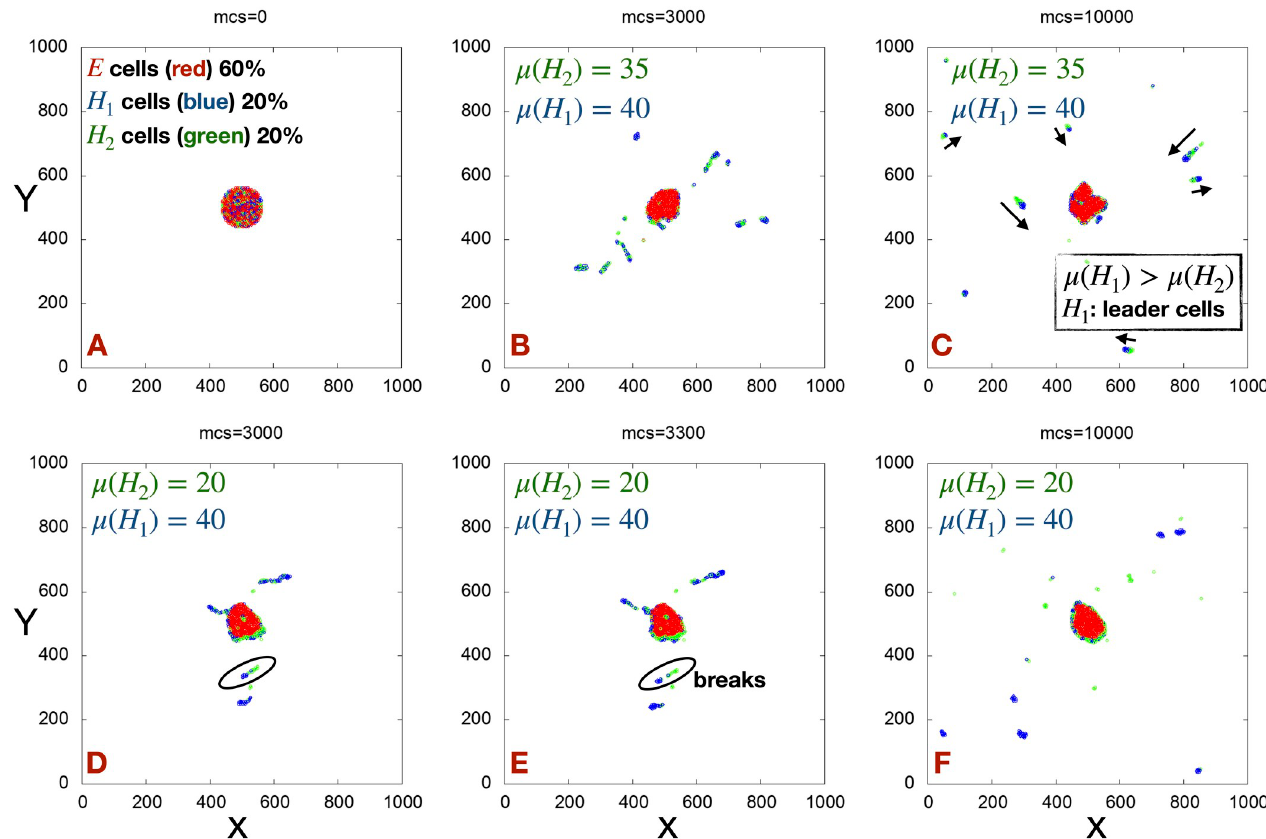
Fig 5. Snapshots of heterogeneous clusters. (A) A representative snapshot of an initial configuration consisting of two kinds of H cells ( H 1 and H 2 ) differing in their motile forces ( μ ). Representative snapshots of the simulations at different mcs for (B-C) μ ( H 1 ) = 40, μ ( H 2 ) = 35 and (D-F) μ ( H 1 ) = 40, μ ( H 2 ) = 20 with a fixed Γ = 3 for all the H cells. The arrow indicates the direction of movement of the clusters. Observe the cluster breaking event occurring inside the black circles. Here, we have plotted the center of mass of the cells.